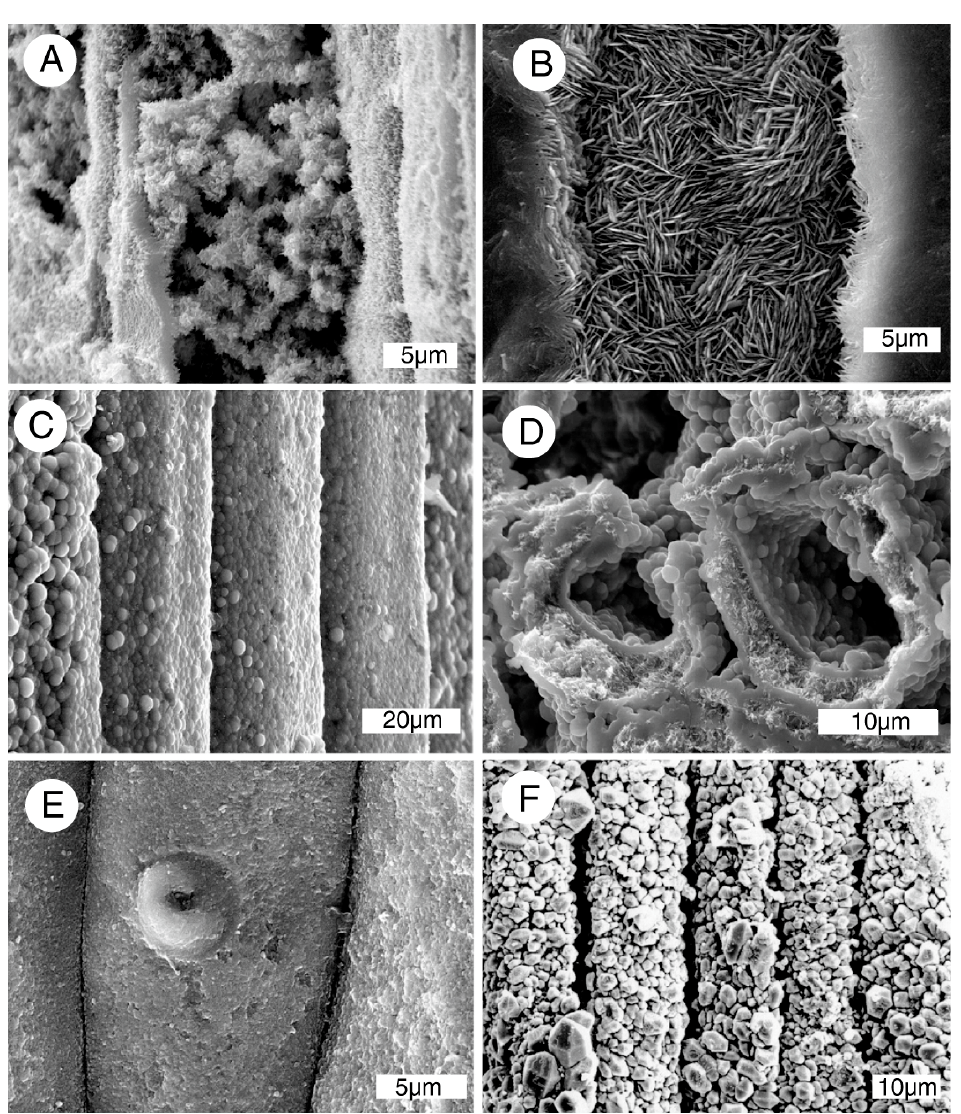
Figure 3. SEM images of silicified woods showing cell walls where anatomical features have been replicated by silica minerals. ( A ) Miocene wood from Schurz, NV, USA, radial orientation showing cells walls replaced by opal-CT; ( B ) Miocene oak, Clover Creek, ID, USA. Radial orientation, interior view of a tracheid replaced by opal-CT; ( C ) Miocene wood, Washoe County, NV, USA. Radial orientation, tracheid walls mineralized with opal-A; ( D ) Miocene wood from Section 27 claim, Virgin Valley, NV, USA, Cell walls show multi-layered architecture, consisting of porous opal-A with surface layer of botryoidal opal-A; ( E ) Eocene wood from Yellowstone River, near Billings, MT, USA. Radial orientation, tracheids architecture mimicked by microcrystalline quartz; ( F ) Cretaceous conifer wood, Trinity County, TX, USA. Radial orientation, tracheids replicated with crystalline quartz.